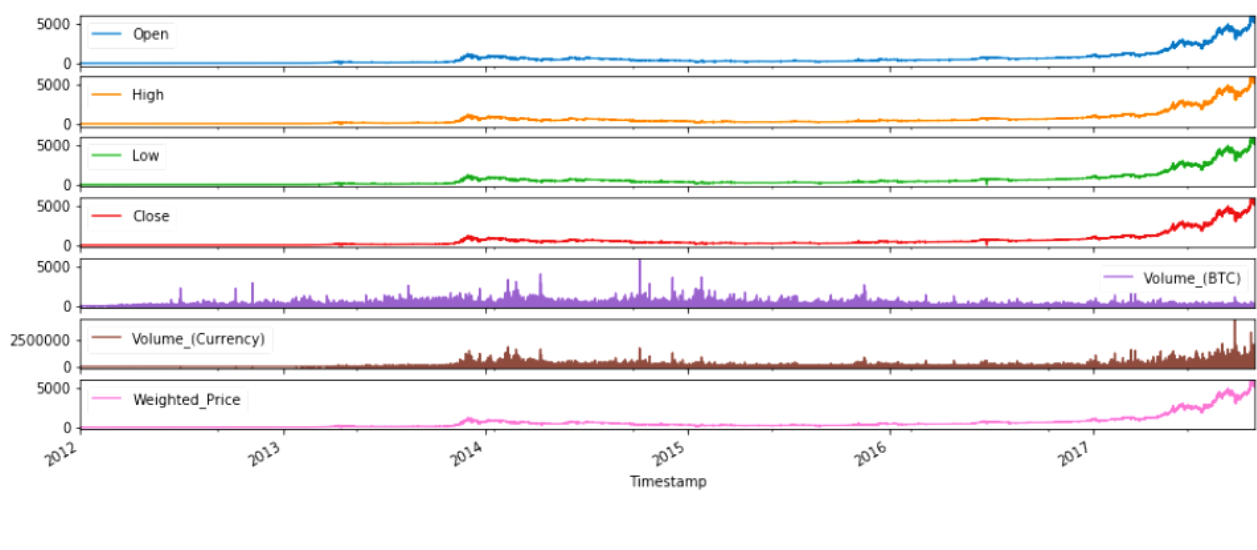
Figure 1. Exploratory Analysis of Each Feature